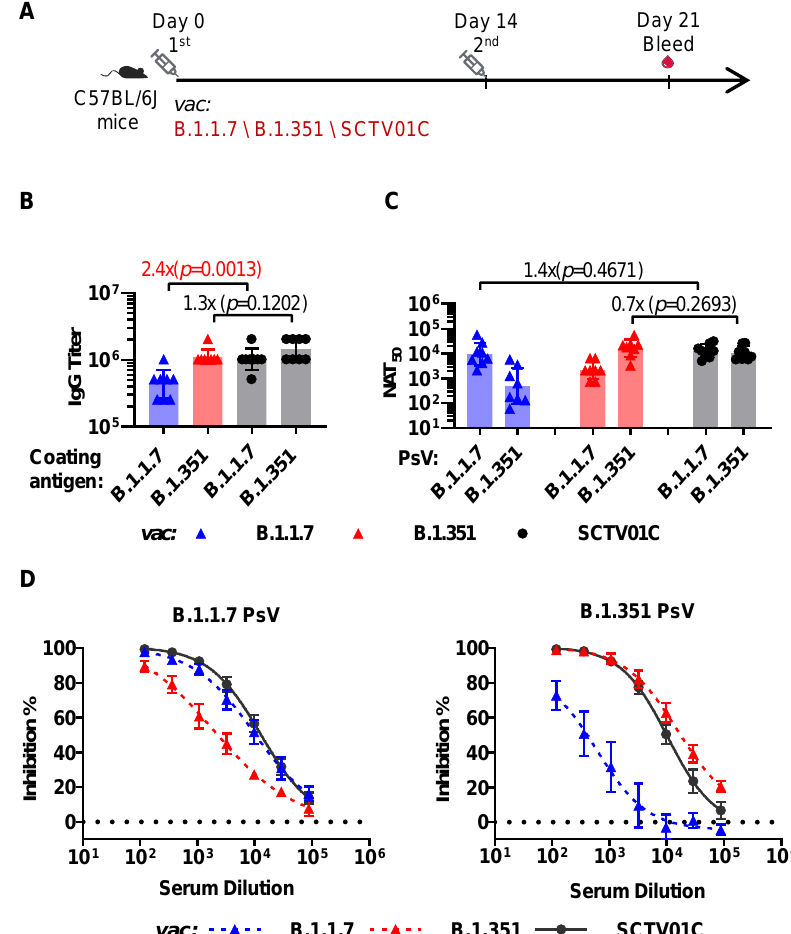
Figure 2. Humoral immune responses induced by the B.1.1.7 monovalent, B.1.351 monovalent and SCTV01C bivalent vaccines with a prime-boost regimen. ( A ) Scheme of immunization and serum collection. C57BL/6J mice (n = 8/group) were immunized with B.1.1.7 monovalent vaccine (1 µ g/dose), B.1.351 monovalent vaccine (1 µ g/dose), or SCTV01C (1 µ g/dose for each antigen) on days 0 and 14. Humoral immune responses on day 21 were analyzed. ( B ) Antigen-specific IgG titer. ( C ) PsV neutralization titer (NAT 50 ) against B.1.1.7 and B.1.351 pseudovirus (PsV). Bars show GMT ± SD. Data were log transformed and analyzed by Student’s t test (unpaired, two-tailed). ( D ) Inhibition rates of immune serum against the B.1.1.7 and B.1.351 PsV. Bars show mean ± SD. The results are representative of 2 independent experiments. Vac is an abbreviation for Vaccine. Dotted line defines the limit of